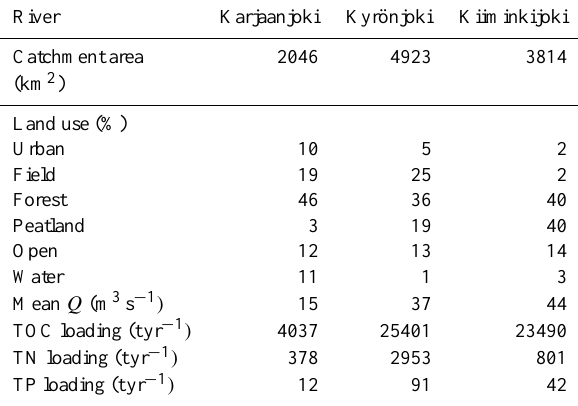
Table 1. Properties of river catchments, average discharges ( Q ), to- tal organic carbon (TOC), total nitrogen (TN) and total phosphorus (TP) loadings during the study period. “Field” includes pasture and cropland, “open” consists of areas with no vegetation and “water” includes lakes, streams, etc. Discharge and loading values are from the database of Finnish Environment (HERTTA, 2012).